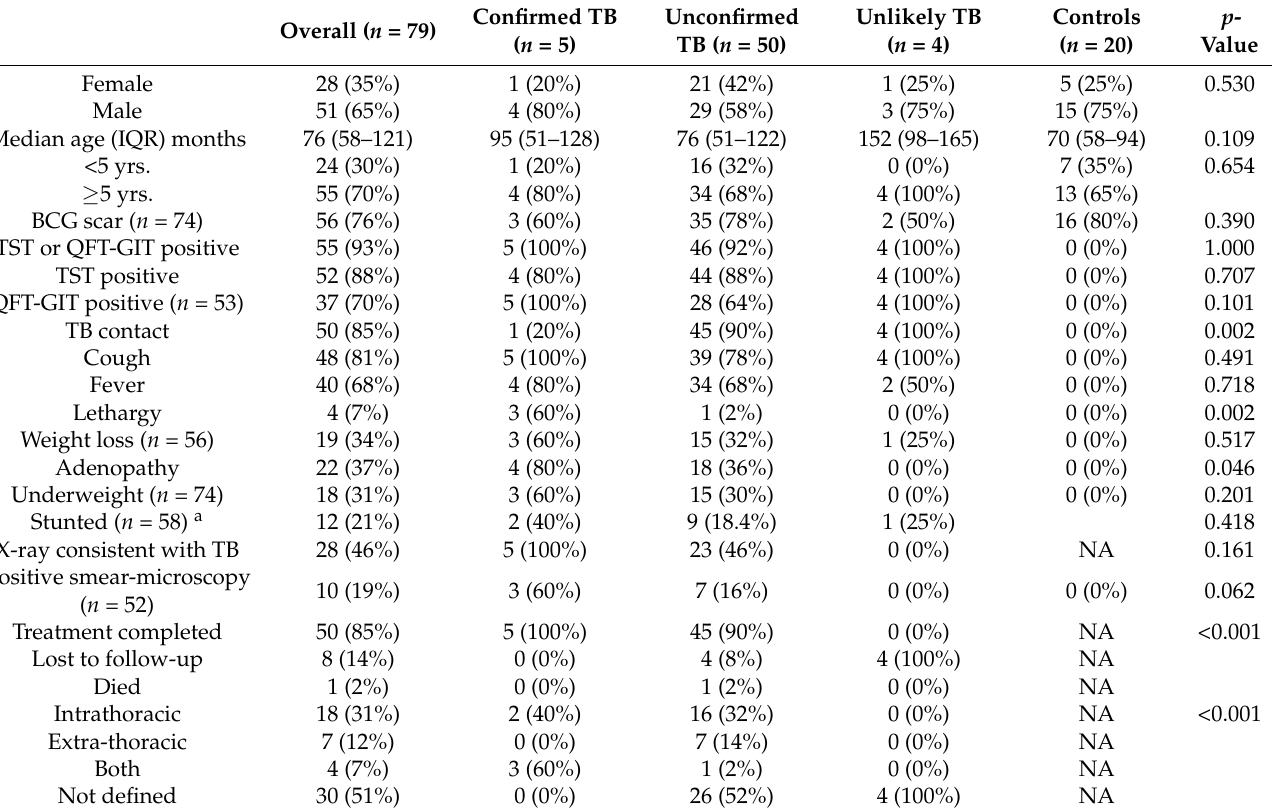
Table 1. Demographic and clinical characteristics of participants.